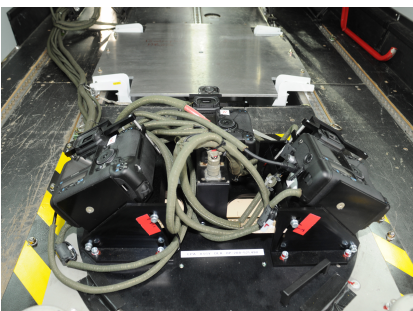
Figure 5: The 3K+ camera system. A low-cost camera system with a higher recording frequency compared to professional pho- tographic camera systems.